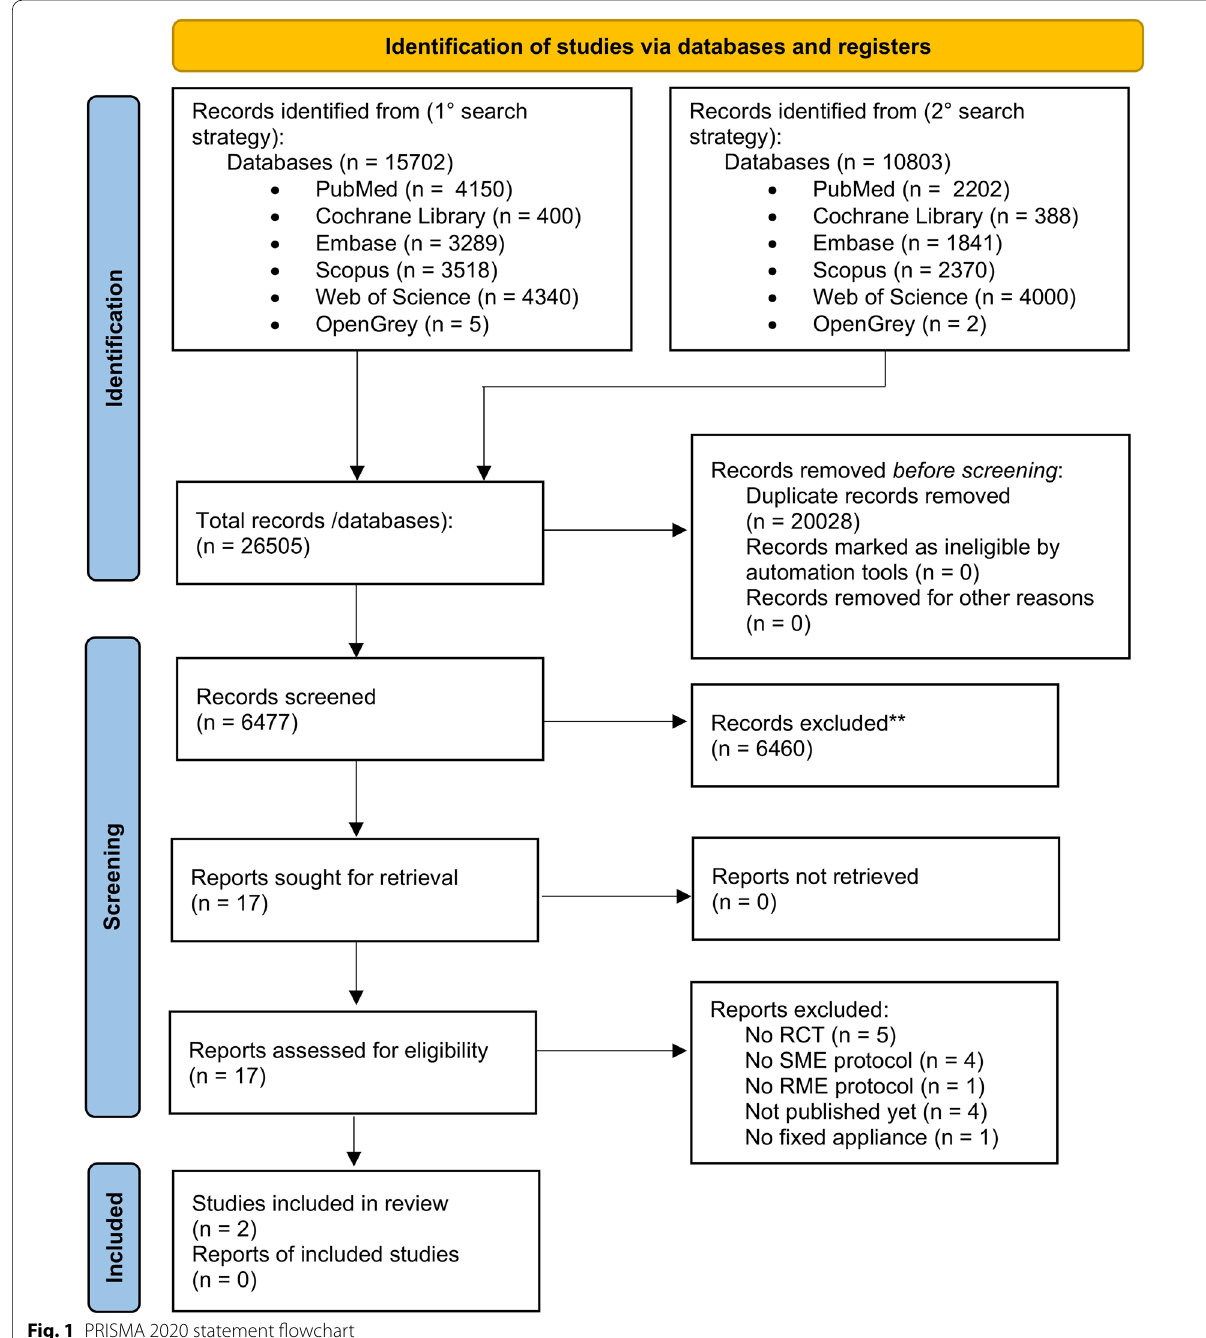
Fig. 1 PRISMA 2020 statement